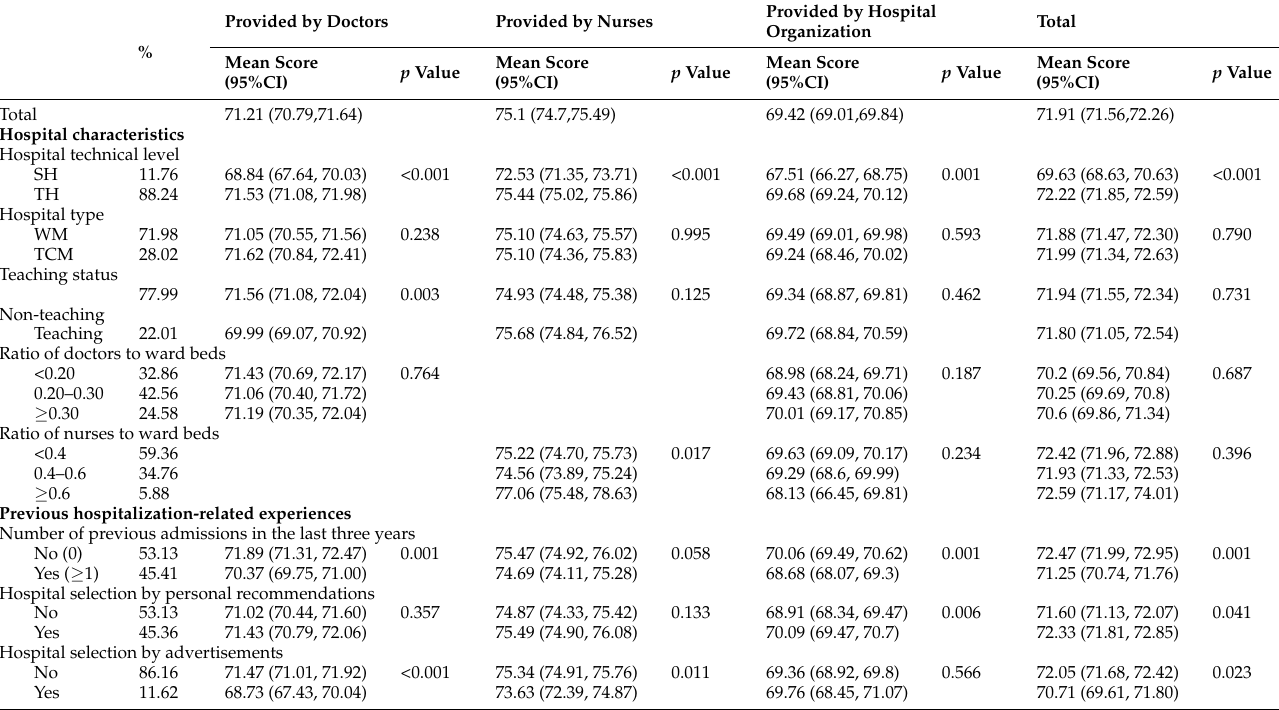
Table 2. Patients’ perceptions of hospital care according to hospital characteristics and patients’ previous hospitalization-related